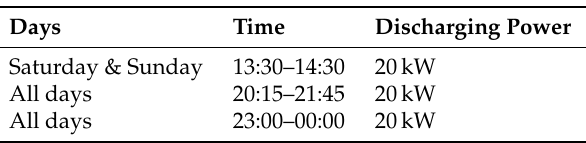
Table 3. Times of battery discharging.